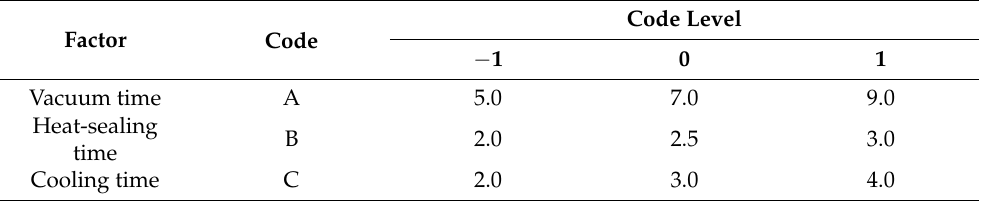
Table 1. Factors and levels in the Box–Behnken test design